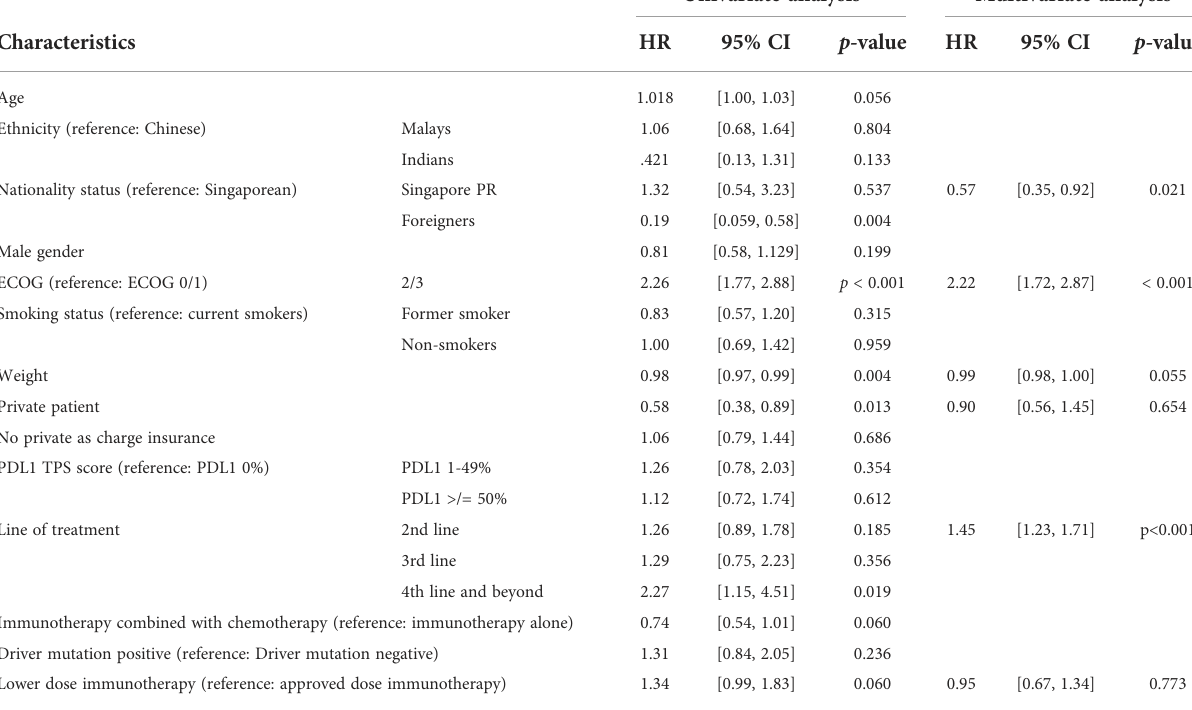
TABLE 4 Univariate and multivariate Cox regression for overall